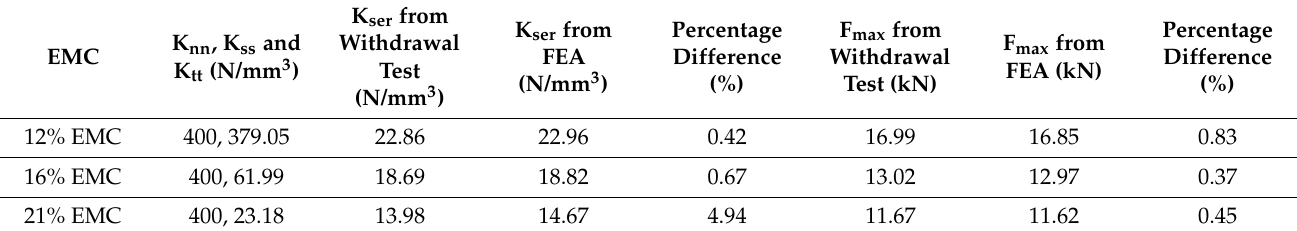
Table 17. 160 × 170 mm CLT calibrated values.